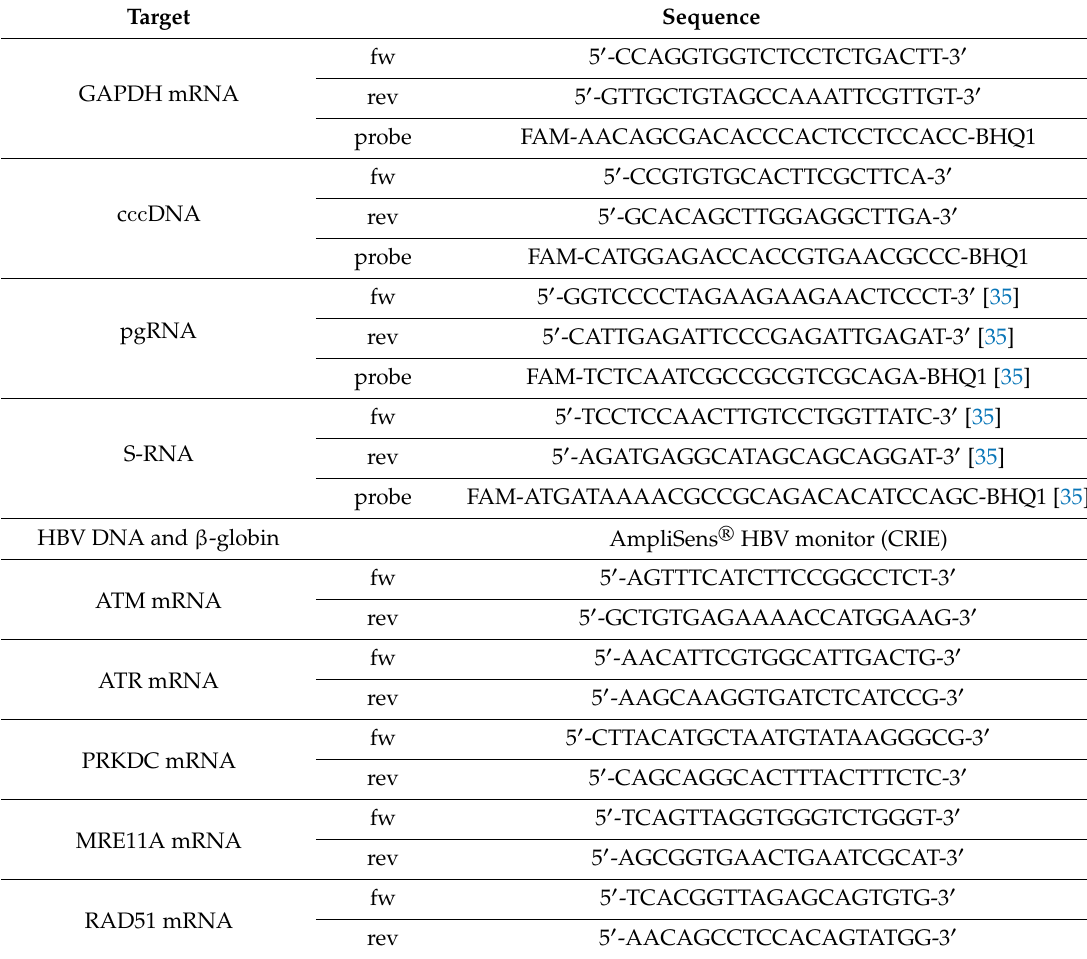
Table 2. Primers and probes used in the